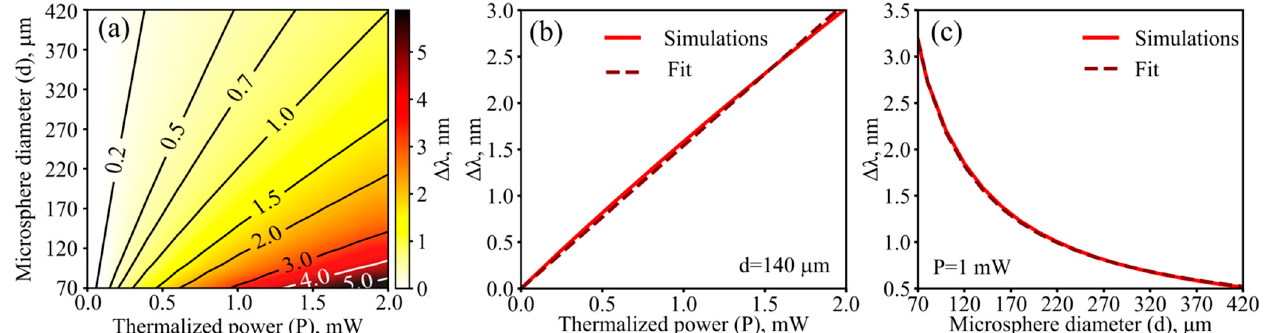
Figure 5. Numerical results. ( a ) Steady ‐ state thermo ‐ optical shift of WGMs, Δλ , as a function of thermalized power and microsphere diameter. ( b ) Δ λ as a function of P for d = 140 μ m and its linear fit. ( c ) Δ λ as a function of d for P = 1 mW and its fit ~1/ d .